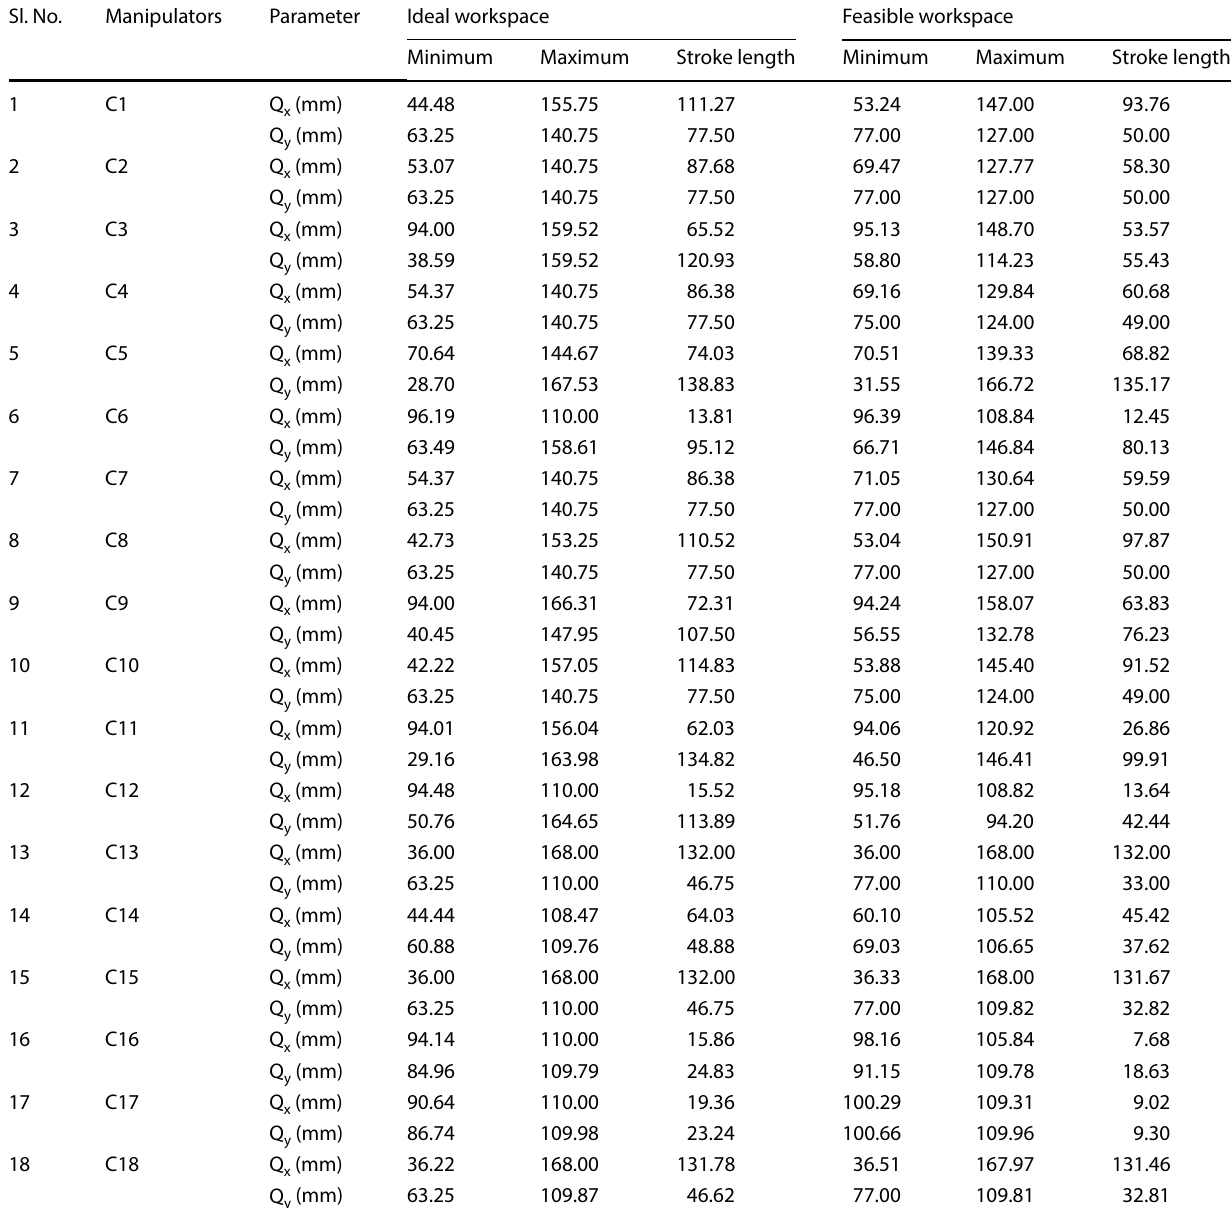
Table 7 Ideal and feasible workspace of all the 18 configured 3-DOF U-shaped base PPMs Sl.